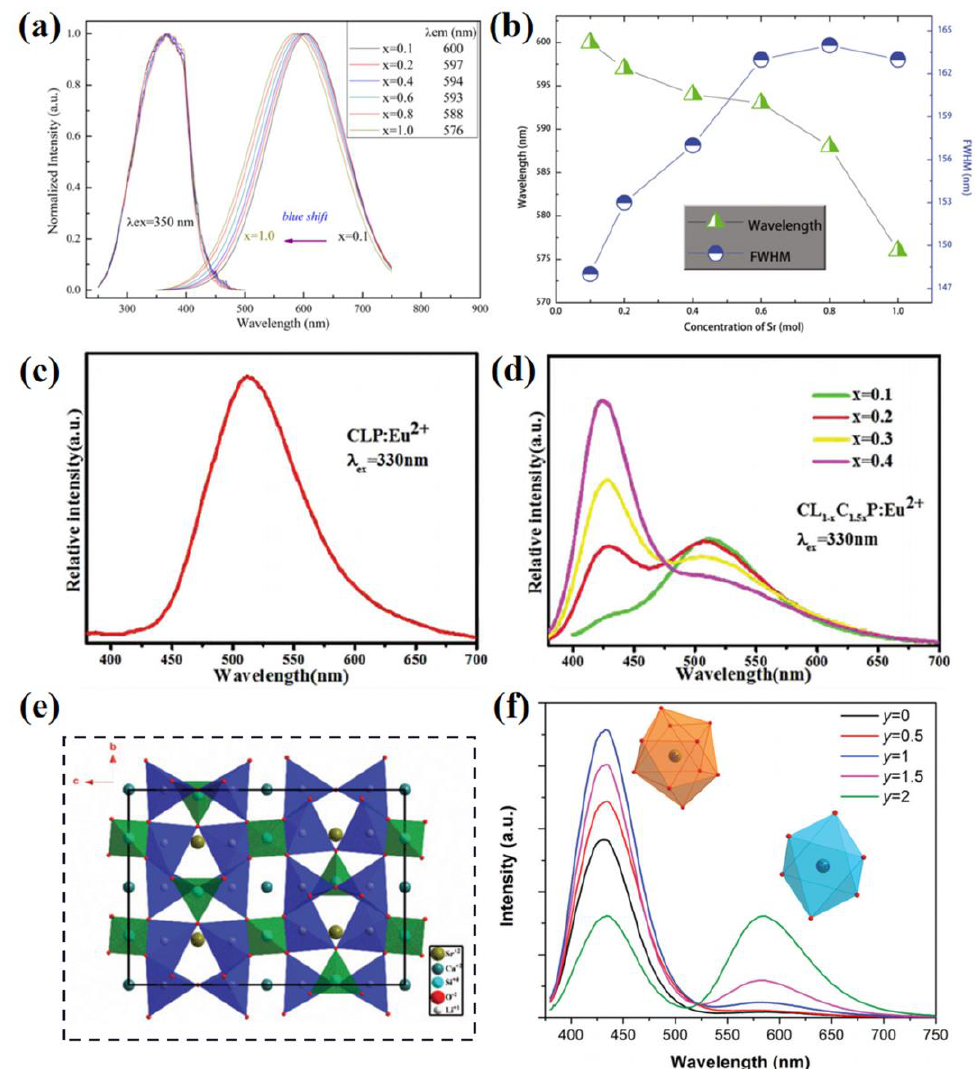
Figure 13. ( a ) Intensities normalized PLE and PL spectra. ( b ) Peak wavelength and the FWHM of samples with nominal formula Ba 0.98(2 − x) Sr 0.98 − x Mg(PO 4 ) 2 :0.04Eu 2+ (x = 0.1, 0.2, 0.4, 0.6, 0.8, 1.0). Reprinted with permission from ref. [38]. Copyright 2015 American Ceramic Society. Emission spectra of ( c ) Ca 9 La(PO 4 ) 7 :Eu 2+ and ( d ) Ca 9 La 1 − x Ca1.5 x (PO 4 ) 7 :Eu 2+ . Reprinted with permission from ref. [89]. Copyright 2019 Royal Society of Chemistry. ( e ) The crystal structure diagram of Li 4 SrCa(SiO 4 ) 2 . ( f ) Emission spectra of Li 4 SrCaSi 2 O 8−2y N 4y−3 :0.05Eu 2+ phosphors (λ ex = 363 nm). Reprinted with permission from ref. [98]. Copyright 2022 Royal Society of Chemistry.